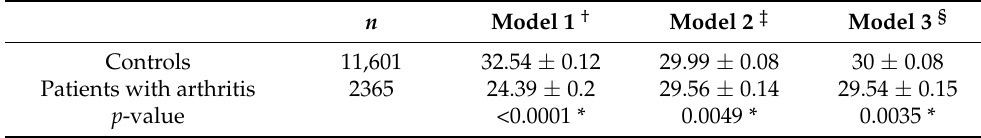
Table 2. Handgrip strength measurement in patients with arthritis and healthy